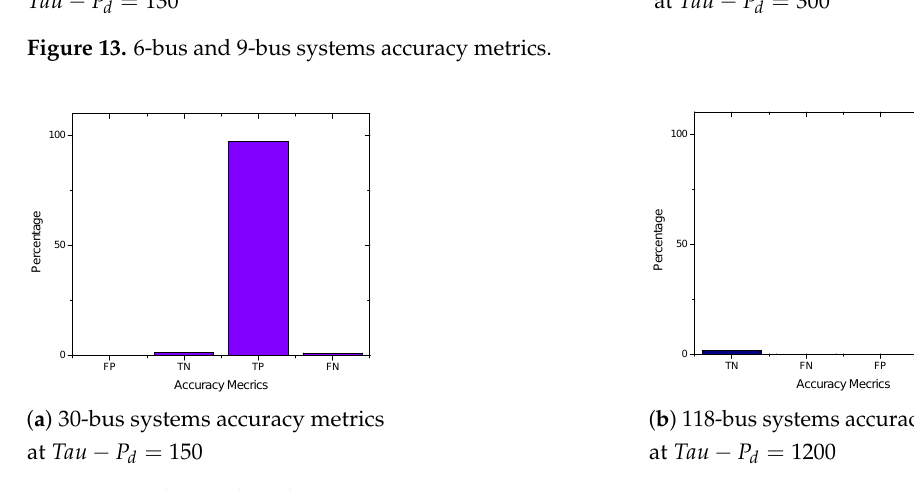
Figure 14. 30-bus and 118 bus systems accuracy metrics.